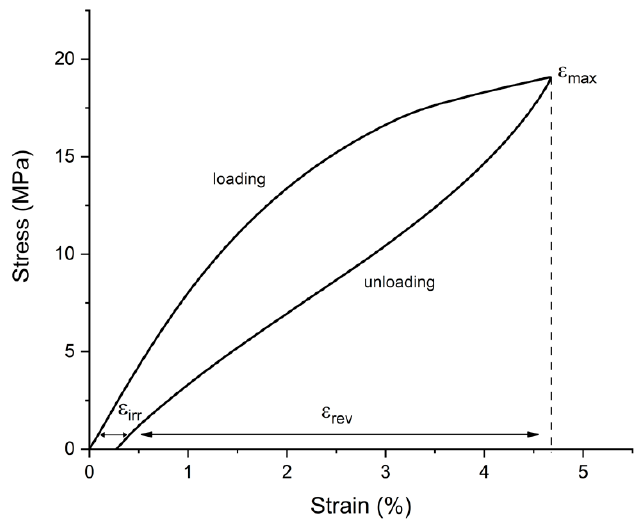
Figure 4. Maximum, reversible, and irreversible (residual) strain determined under the superelas ‐ ticity effect.